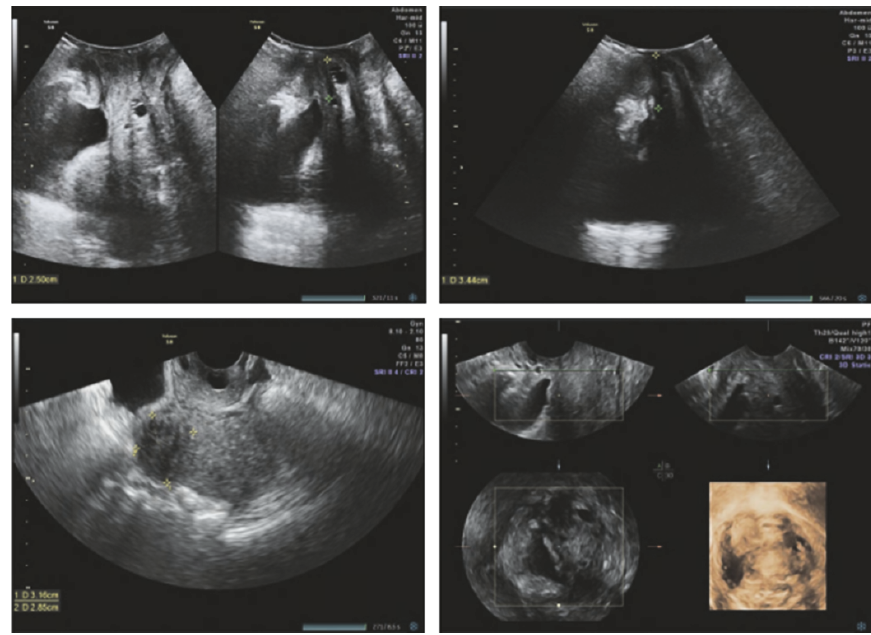
Figure 2: Pelvic floor four-dimensional ultrasound of Case 2. Pelvic floor four-dimensional ultrasound indicated that residual urine was 0 ml, thickness of detrusor was normal, internal orifice of urethra was closed, posterior angle of bladder was intact, and there was no dark area of liquid and scattered point of calcification around urethra in quiescent condition. CDFI revealed that sparse color flow signals were seen around the urethra, the bladder neck was 19 mm above the pubic symphysis, the uterus was 17 mm above the pubic symphysis, and ampulla portion of rectum was located at the pubic symphysis. Bladder neckdisplacement was 15 mm, bladder neck was located9 mm below the pubic symphysis, posterior angle of bladder was intact, the uterus was 35 mm below the pubic symphysis, ampulla portion of rectum was located at the pubic symphysis, rectocele was not seen, and anal sphincter was complete in